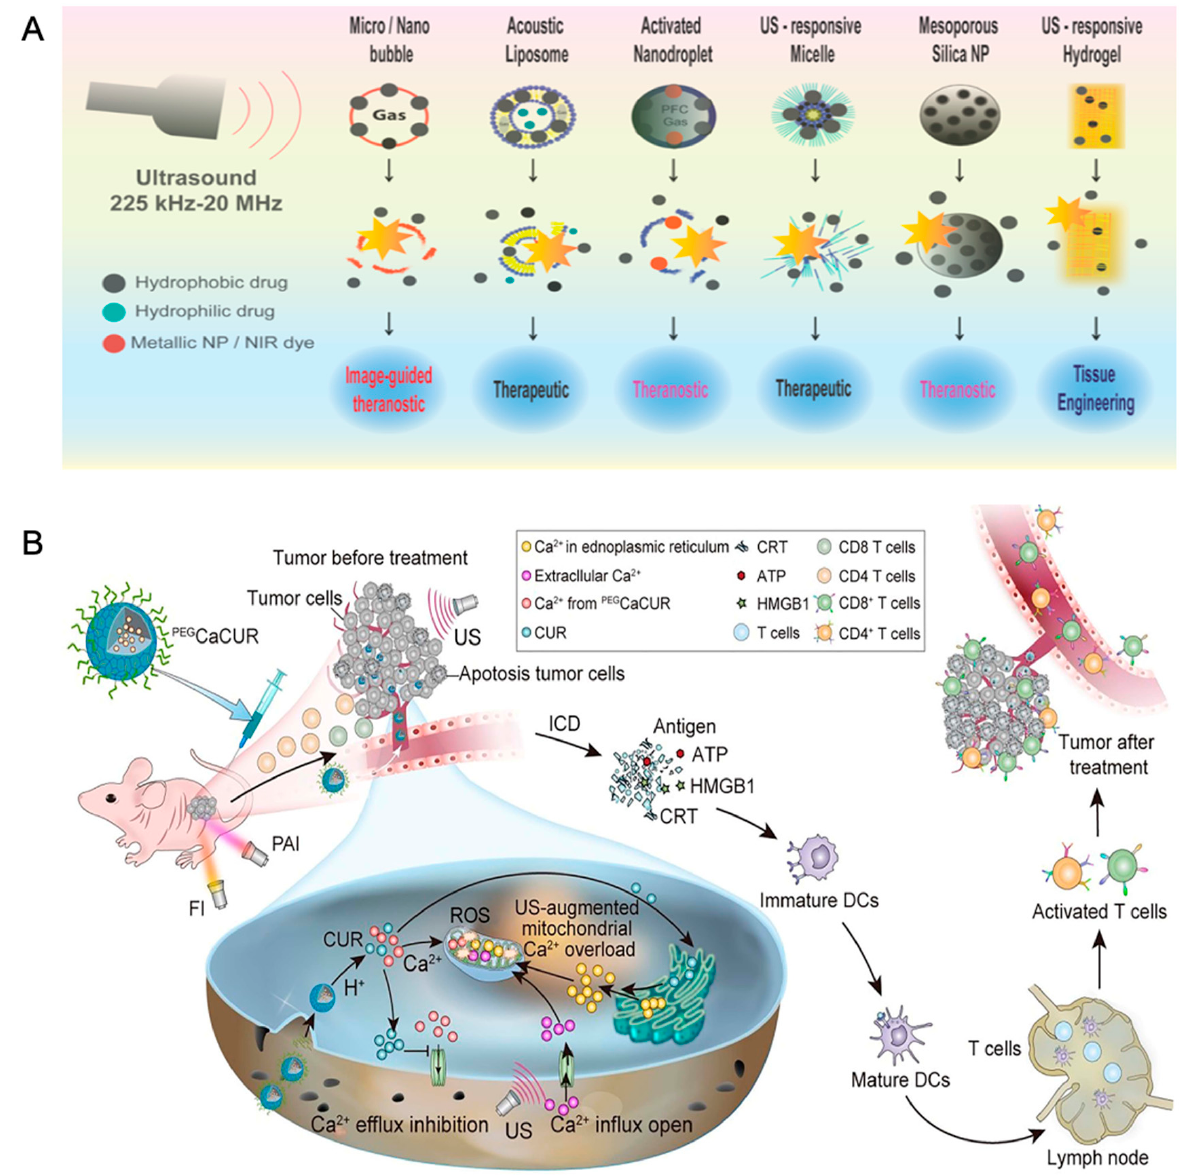
Figure 8. ( A ) Scheme of ultrasound-responsive nanoparticles for therapeutic applications. Reprinted with permission from Ref. [77]. Copyright 2014, Banerjee, R.; ( B ) Scheme of Photoacoustic/Fluorescence Dual-responsive nanoparticles induced mitochondria calcium ion overload leading to immunogenic cell death. Reprinted with permission from Ref. [76]. Copyright 2016, Chen, X.